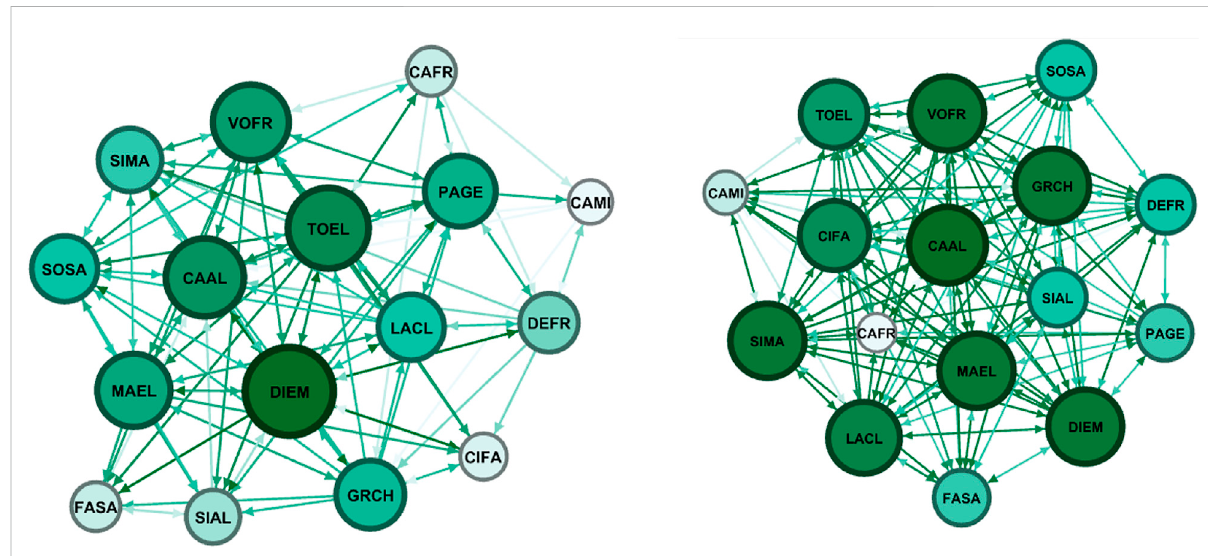
FIGURE 1 Pre-Test (on the left) and post-test (on the right) Sociograms on affective/relational dimension for the group involved in the trial.